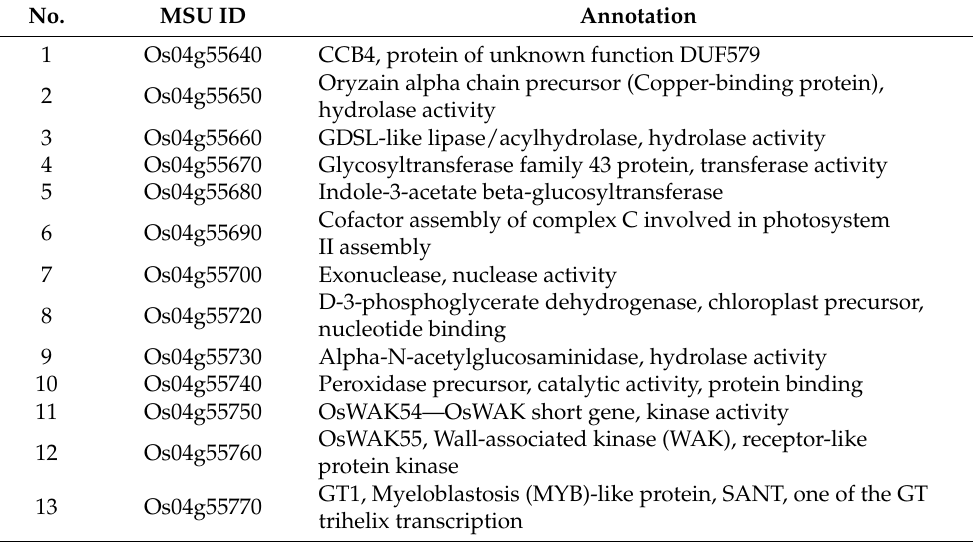
Table 1. List of genes located in the qBK4 T